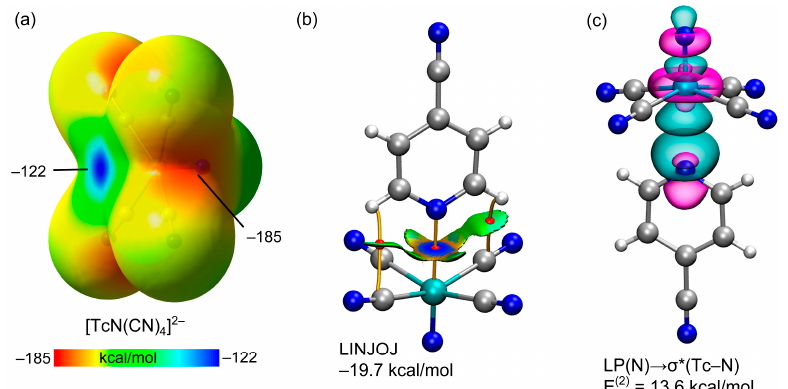
Figure 8. ( a ) MEP surface of [TcN(CN) 4 ] 2 − (isosurface 0.001 a.u.). Energies at selected points in kcal/mol. ( b ) QTAIM/NCIPlot analysis of the heterodimer of LINJOJ with indication of the dimerization energy. ( c ) Plot of the NBOs involved in the donor–acceptor interaction with indication of the E (2) energy. Color code: Carbon grey, Nitrogen blue, Technetium teal, Hydrogen light